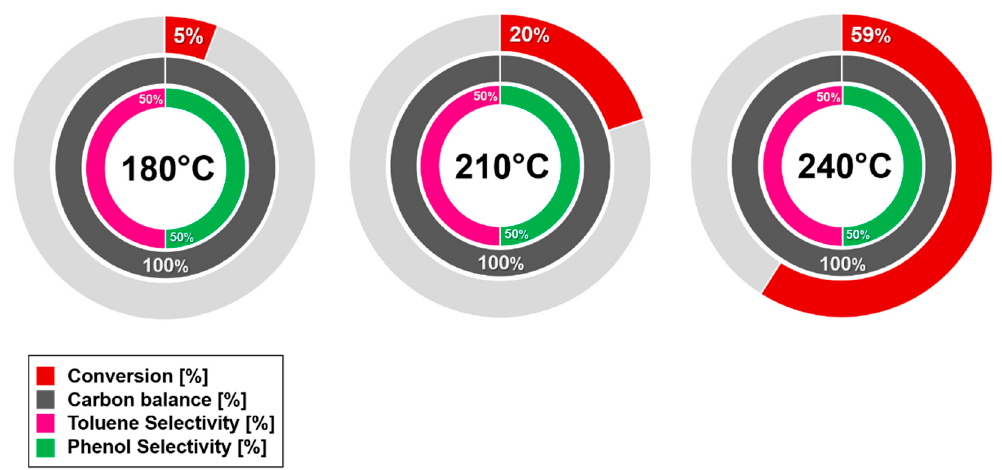
Figure 7. Reaction temperature effect in the catalytic transfer hydrogenolysis (CTH) of BPE in the presence of Pd/Fe 3 O 4 [wnf] catalyst and 2-propanol as solvent/H-source (reaction conditions: 0.125 g of catalyst; 40 mL of 0.1 M BPE solution; time, 90 min; N 2 pressure, 10 bar; stirring, 500 rpm).